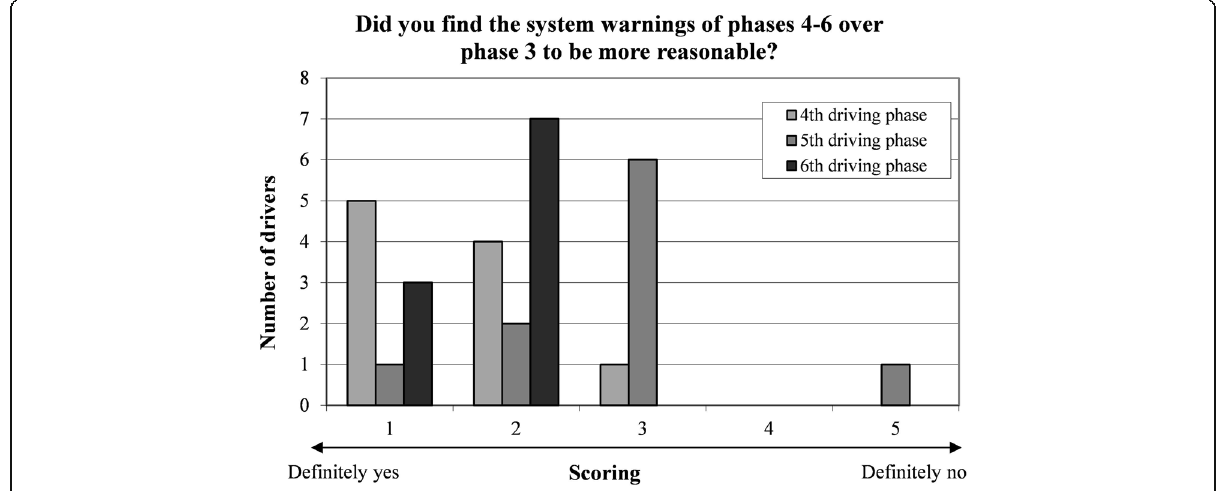
Fig. 4 Results for the users ’ opinion on the warnings comparing the system of the 3rd driving phase to those of the phases 4 – 6